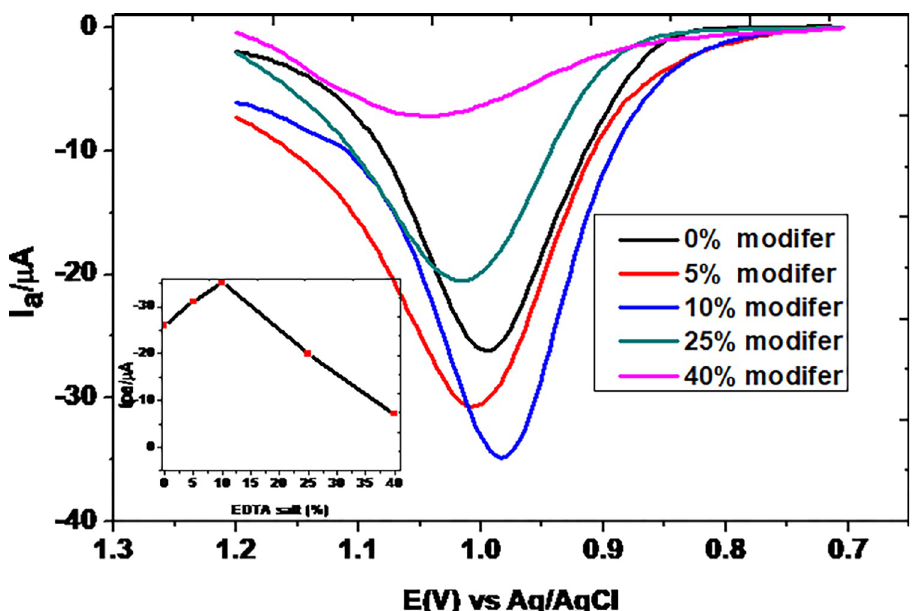
Fig 10. Corrected for blank SWVs of 0.5 mM TP in pH 7.0 PBS at MCPE fabricated with various EDTA salt ratio (0, 5, 10, 25, and 40%).